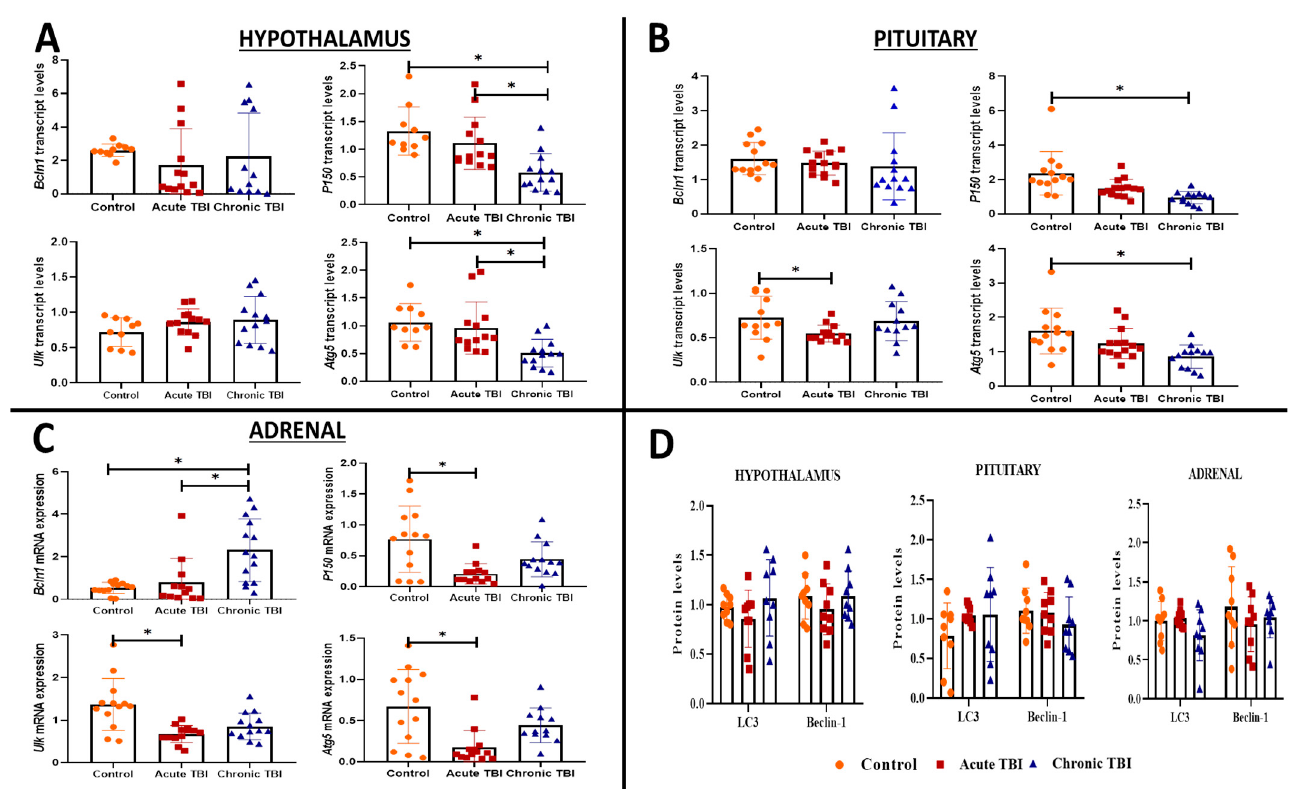
Figure 2. The transcript levels of Bcln1, P150, Ulk , and Atg5 genes and protein levels of LC-3, Beclin- 1 in the hypothalamus, pituitary, and adrenals in the acute and chronic phases after TBI. ( A ) The transcript levels of Bcln1, P150, Ulk, and Atg5 genes in the hypothalamus after TBI in the acute, chronic, and control groups ( A – D ) (Bar Graph) (* p < 0.05). Box plots are expressed as mean ± SD (n = 14 rats in each group). ( B ) The transcript levels of Bcln1, P150, Ulk, and Atg5 genes in the pituitary after TBI in the acute, chronic and control groups ( A – D ) (Bar Graph) (* p < 0.05). Box plots are as mean ± SD (n = 14 rats in each group). ( C ) The transcript levels of Bcln1, P150, Ulk, and Atg5 genes in the adrenals after TBI in the acute, chronic and control groups ( A – D ) (Bar Graph) (* p < 0.05). Box plots are expressed as mean ± SD (n = 14 rats in each group). ( D ) The protein levels LC-3 and Beclin-1 protein levels in the hypothalamus, pituitary, and adrenals after TBI in the acute, chronic, and control groups. Data are presented as mean ± SD (n = 9 rats in each group). All experiments were independently repeated at least twice.